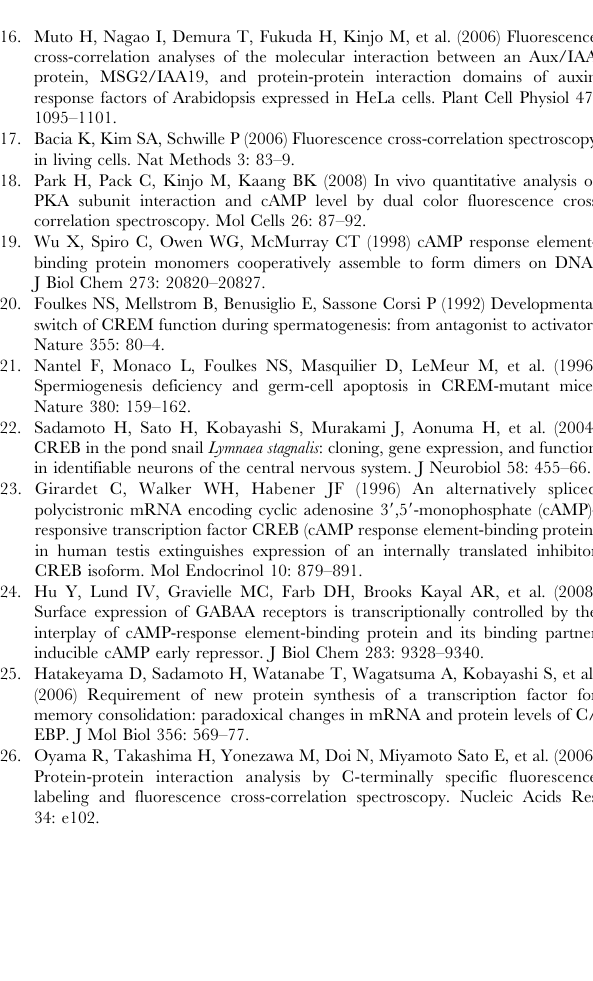
EGFP-Rep and mRFP-Rep (right hatched bar), EGFP-Act mut and mRFP-Act (left open bar), and EGFP protein and mRFP-Act (right open bar). Black bar: CREB1 heterodimer. Hatched bar: CREB1 homodimer. Open bar: negative control. *, P , 0.001 vs. negative